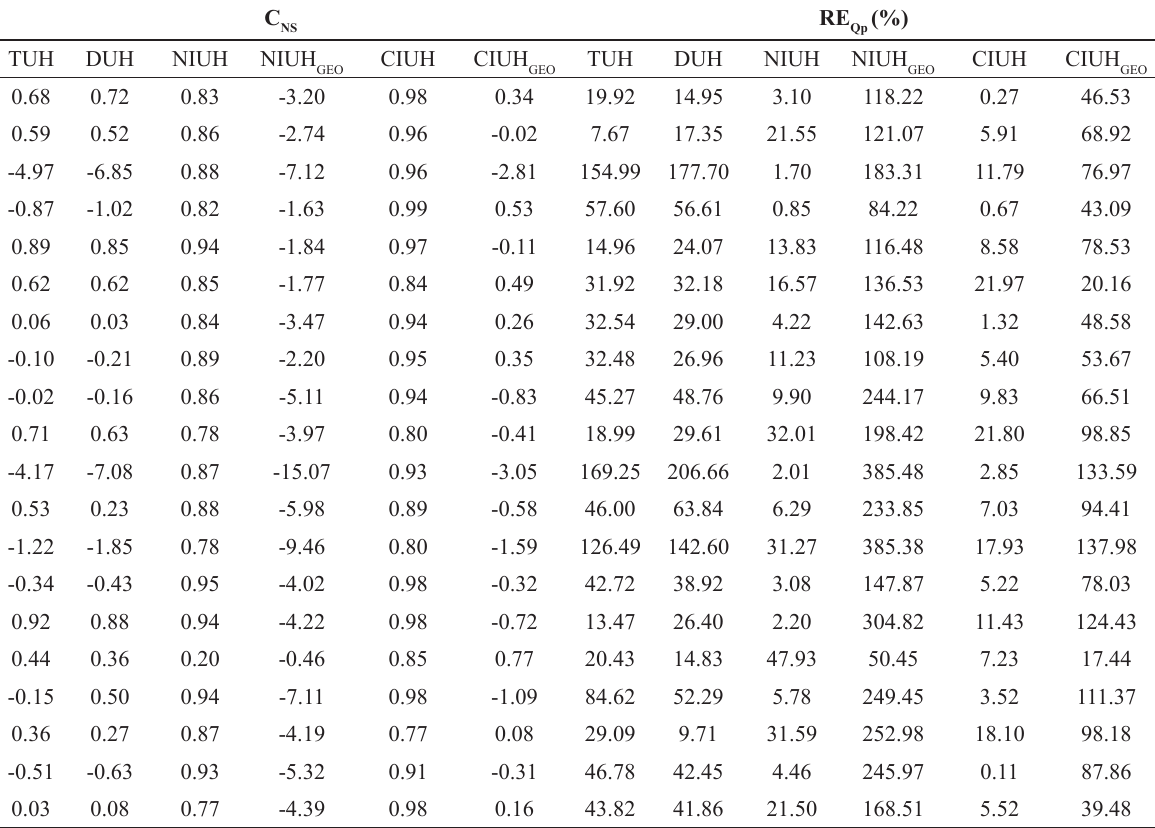
Nash-Sutcliffe coefficient (C ) and peak stream flow relative error (RE NS JCW, considering the UH and IUH models analyzed in this